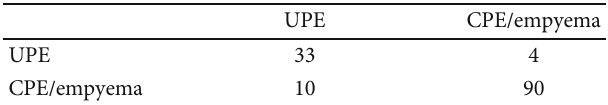
Table 1: Interobserver agreement. Rows represent Pathologist A, with columns representing Pathologist